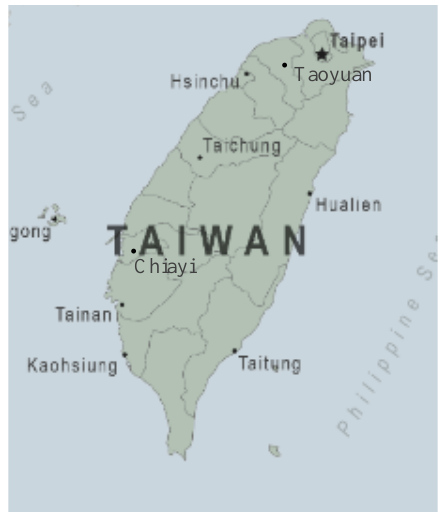
Figure 3. Taiwan Figure 3. Taiwan map.